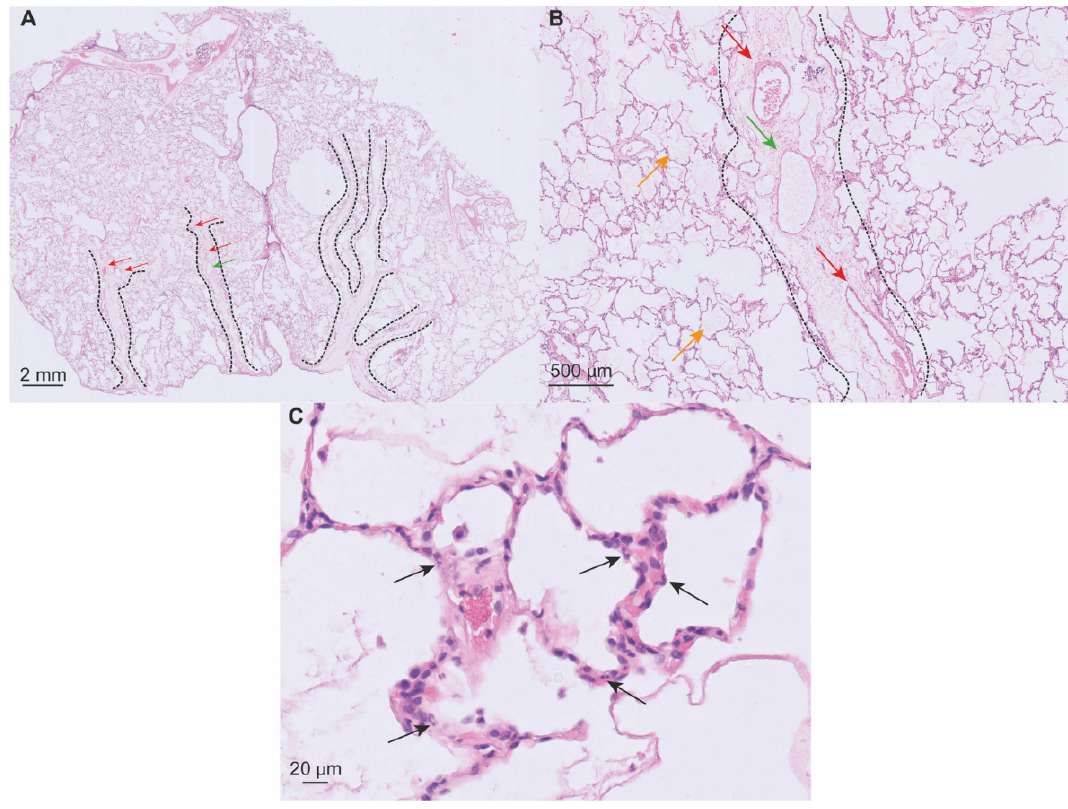
Figure 6. Hematoxylin and eosin stained 5 µm slice of a lung biopsy sampled in a LTx case with severe intraoperative PGD. ( A ) Overview of the section showing widening of interlobular septa containing venules (red arrows) and the lymphatics channels (green arrow) that drain to the subpleural space. ( B ) Alveoli flooded with proteinaceous exudate (orange arrows); widening of interlobular septum (dashed line) with engorgement of lymphatic vessels (green arrow); septal venule (red arrows) ( C ) Mild interstitial inflammation with presence of neutrophils (black arrows).